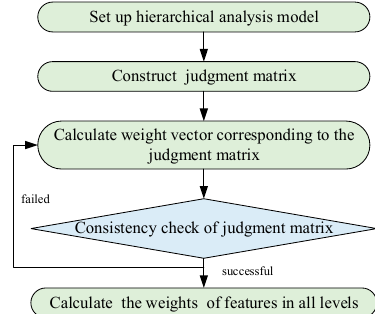
Figure 7. Weight coefficients evaluation process based on analytic hierarchy process (AHP).